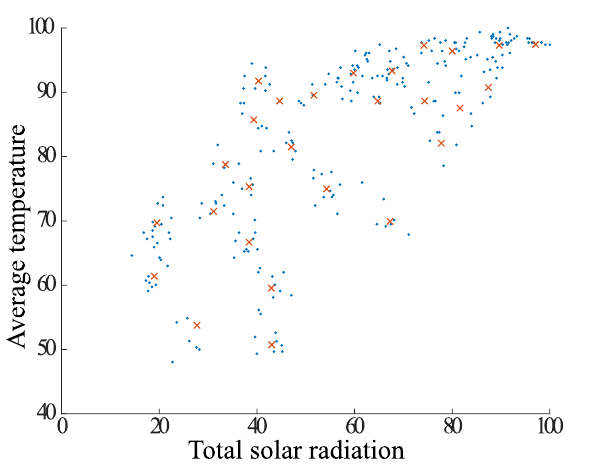
Figure 17. Step 7 result.